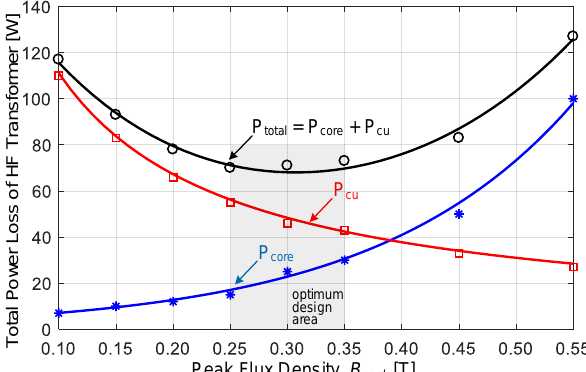
Figure 17. HF transformer power loss against peak flux density (23 kW, 700 V peak secondary voltage, f sw = 20 kHz and n = 1.52 for SU102b nanocrystalline core).